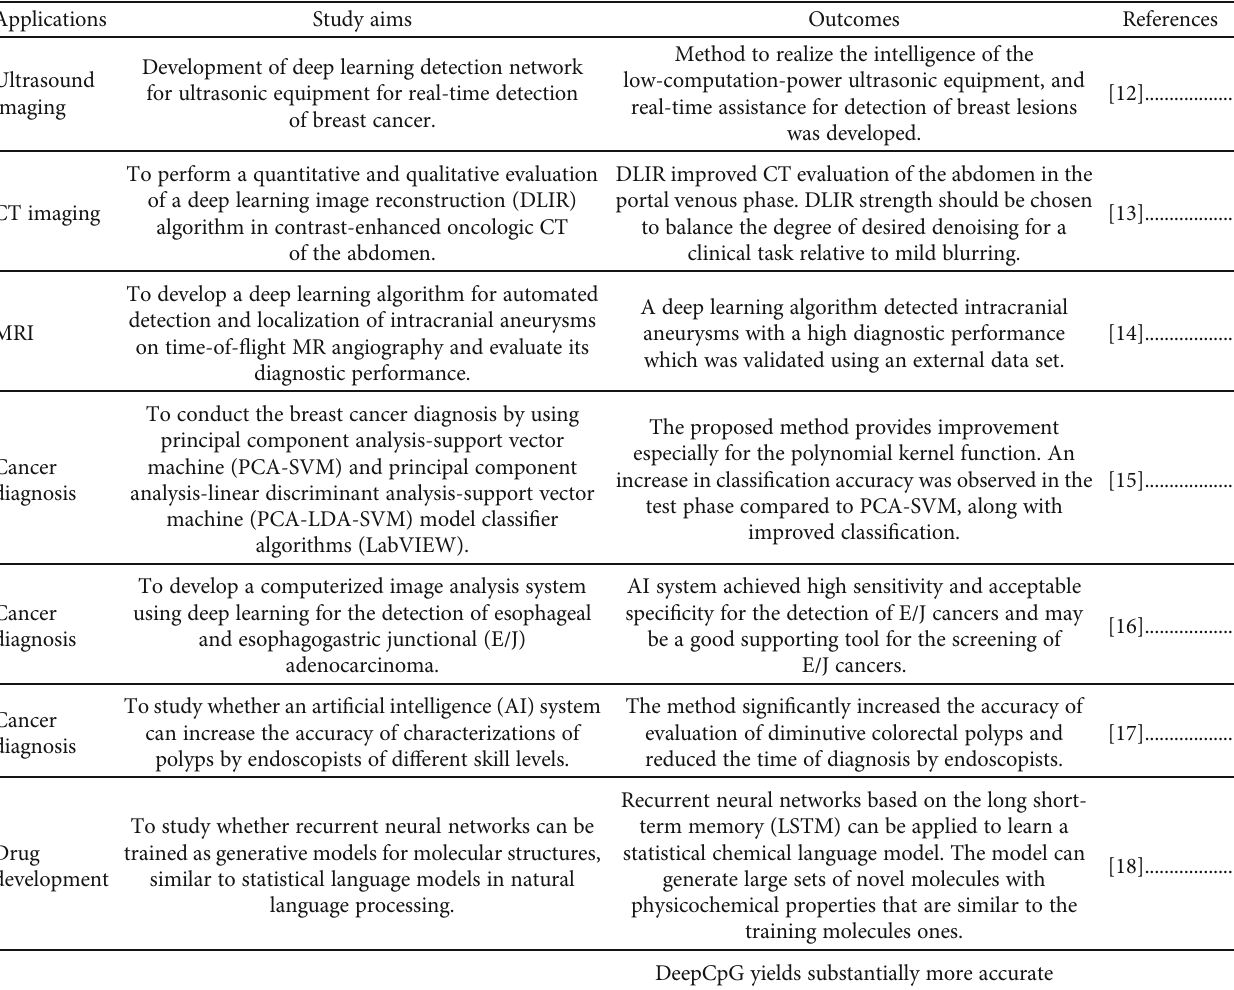
Table 1: Examples of AI applications in